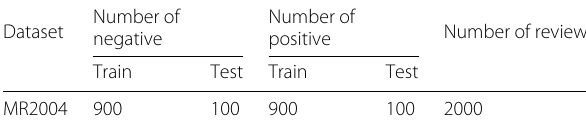
Table 1 The details of MR dataset [27] Dataset